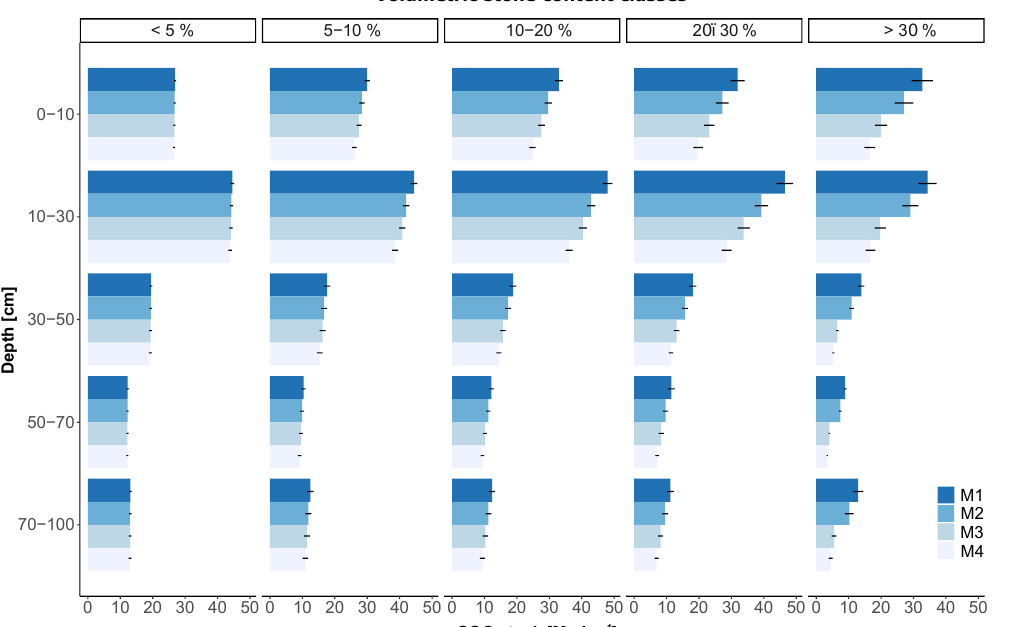
Figure 1. Average soil organic carbon stocks of the German Agricultural Soil Inventory in different depth increments calculated by different calculation methods (M1–M4) for five volumetric rock fragment content classes. Error bars indicate standard